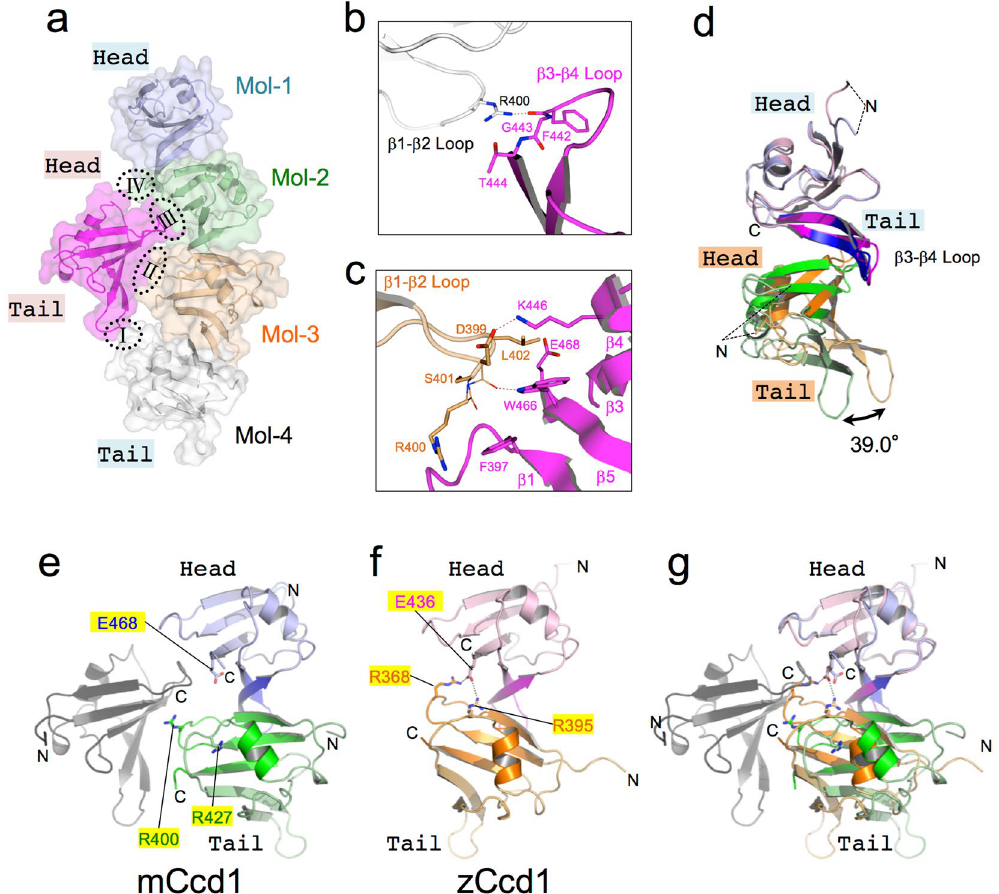
Figure 3. Molecular interactions in the mCcd1 double-helical homopolymer. ( a ) Contact interfaces. The mCcd1 DIX domain (magenta) has contact interfaces with four molecules (blue, green, orange, and white) of another intertwined head-to-tail helical filament. Contact sites I and IV are created between loops β 1- β 2 and β 3- β 4, and contact sites II and III are formed by the interaction of loop β 1- β 2 with β -sheet β 1- β 5- β 3- β 4. ( b , c ) Close up view of contact site I ( b ) and II ( c ). Residues involved in the formation of the contact site are shown as stick models. Electrostatic bonds are indicated by dashed lines. ( d ) Superposition of mCcd1 and zCcd1 homodimers. Head-to-tail interfaces are colored blue and green in mCcd1, and magenta and orange in zCcd1, respectively. The resultant angular differences are indicated by a double-headed arrow. ( e ) Interference of the mCcd1 double-helical homopolymer with electrostatic bond formation in the head-to-tail interface. The mCcd1 homodimers in the head-to-tail helical polymer are colored blue and green, respectively; the interacting molecule is colored black. The three residues, Arg400, Arg427, and Glu468, involved in the formation of electrostatic bonds are highlighted and shown as stick models. The double-helical mCcd1 polymer blocks the formation of electrostatic bonds between the three residues by inserting loop β 1- β 2 into the head-to-tail interface. ( f ) Residues involved in the formation of the zCcd1 single-helical filament. Electrostatic bonds are indicated by black dashed lines. Arg368, Arg395, and Glu436 (highlighted) form two electrostatic bonds in the head-to-tail interface. ( g ) Superposition of mCcd1 and zCcd1